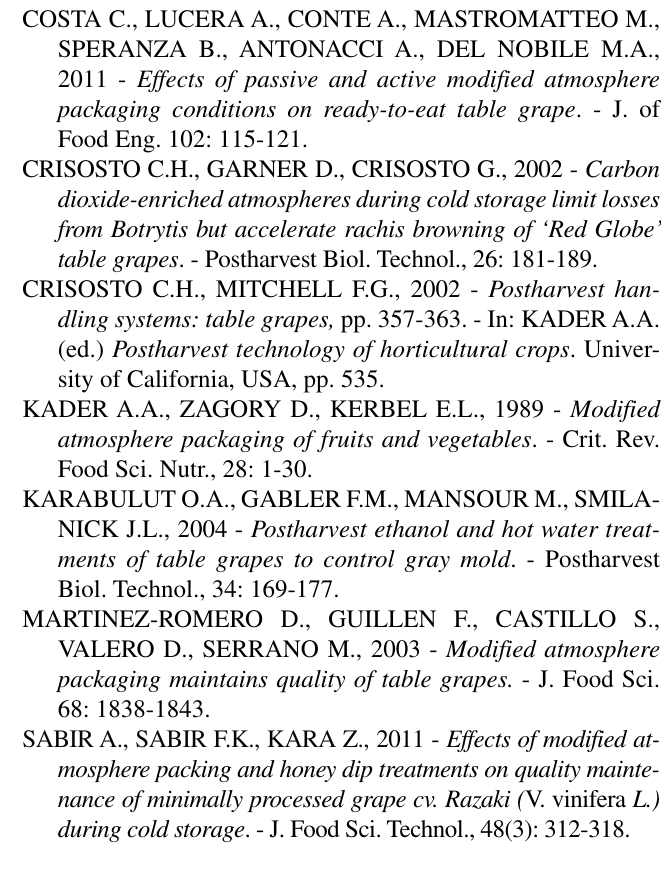
table grapes . - Postharvest Biol. Technol., 26: 181-189.